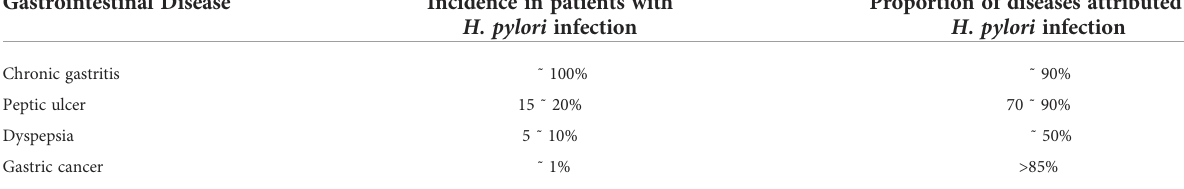
TABLE 1 Incidence of H. pylori infection-associated disease in infected individuals and the proportion attributable to infection. Gastrointestinal Disease